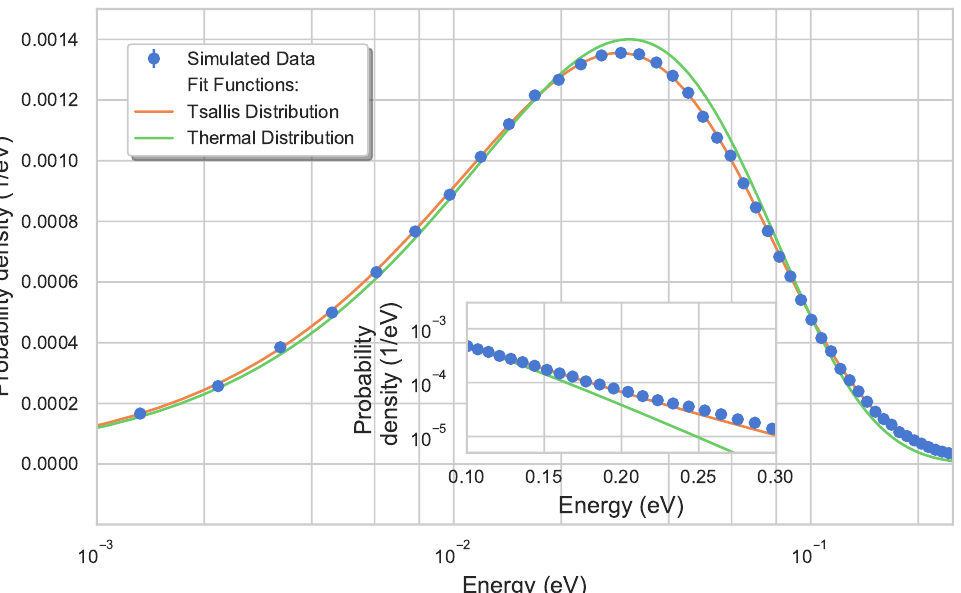
Figure 5. Simulated energy distribution of ions thermalized with a 293 K helium buffer gas in the HAI-trap potential landscape. The energy of the ions is characterized via a Tsallis with T = 313 ( 2 ) K and q = 1.070 ( 2 ) as well as a Maxwell distribution with T = 359 ( 3 ) K. It can be seen that the Maxwell fit overestimates the relative amount of low-energy to mid-energy and underestimates the high-energy tails which are then better represented via a Tsallis distribution (as shown in graph